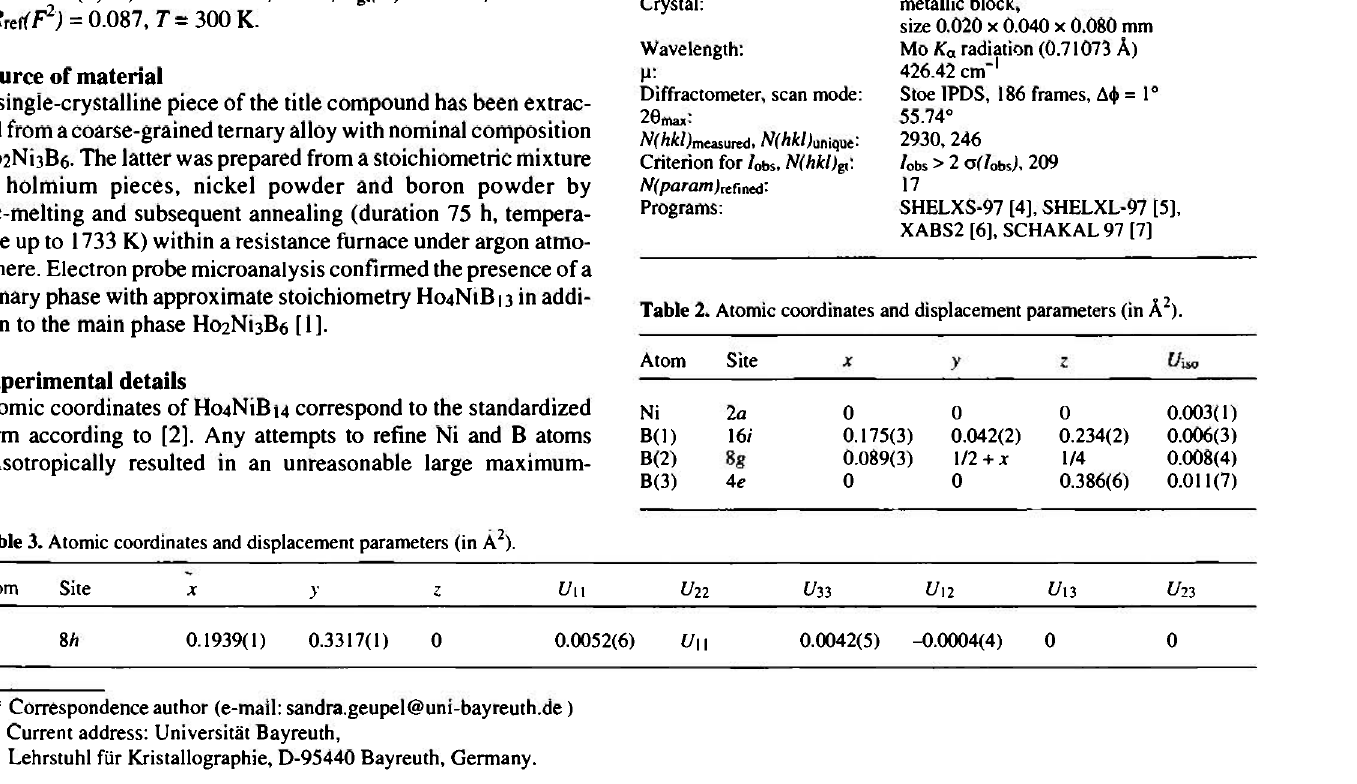
Table 1. Data collection and handling.